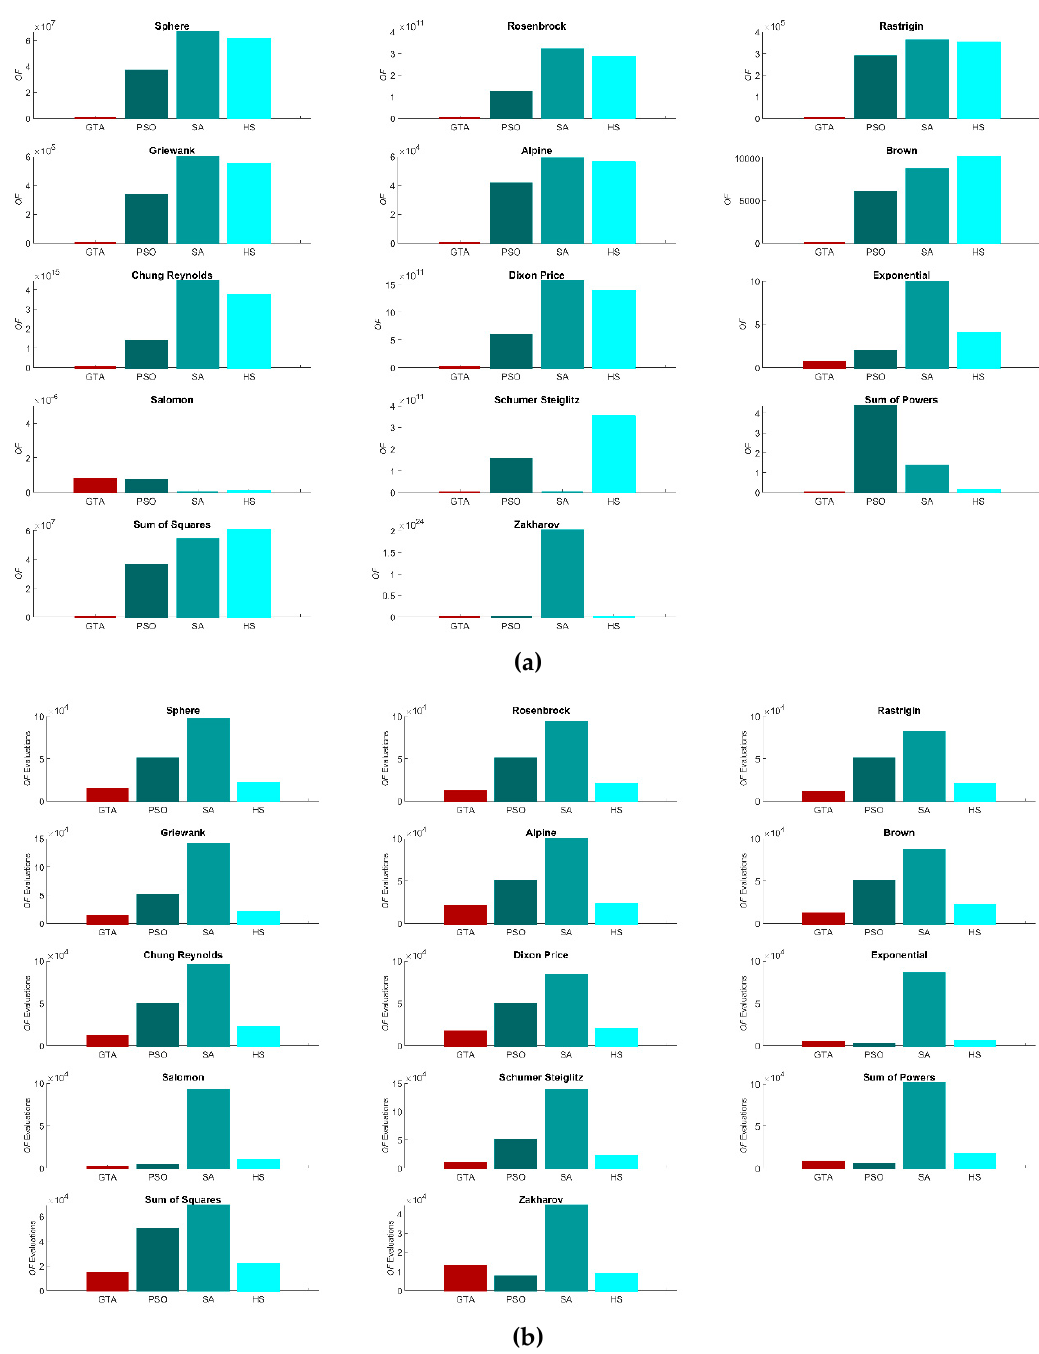
Figure 4. Results of 100 runs with 20,000 variables: ( a ) OF value average; ( b ) OF evaluations average.